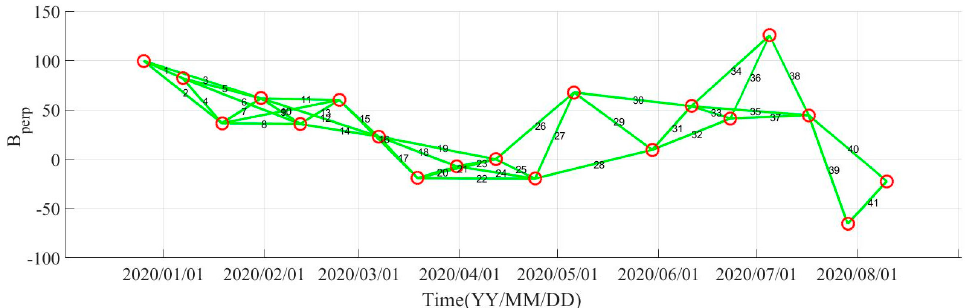
Figure 11. The space–time baseline map of Sentinel-1A images.